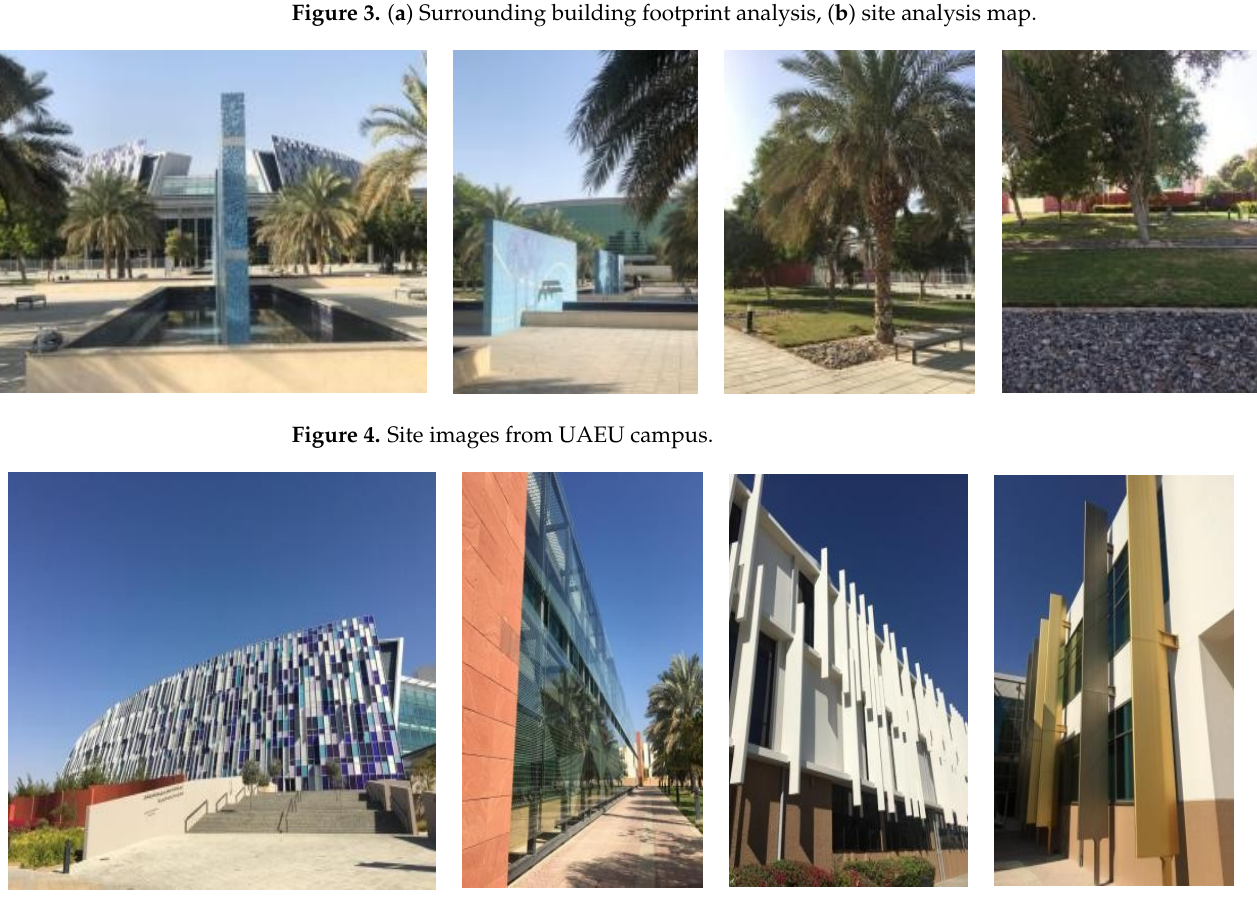
Figure 5 . Images of the façades of the buildings surrounding the selected site. Figure 5. Images of the façades of the buildings surrounding the selected